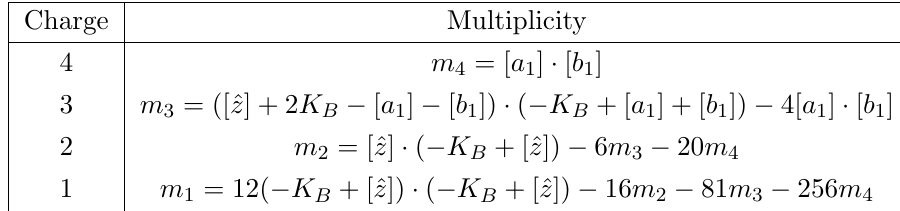
Table 7 . Matter multiplicities for the q = 4